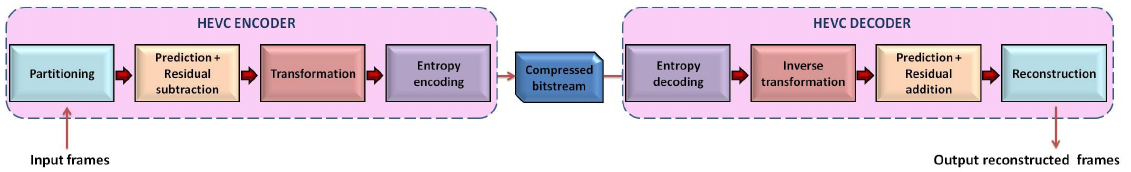
Figure 5. The workflow of the encoding and decoding steps of HEVC